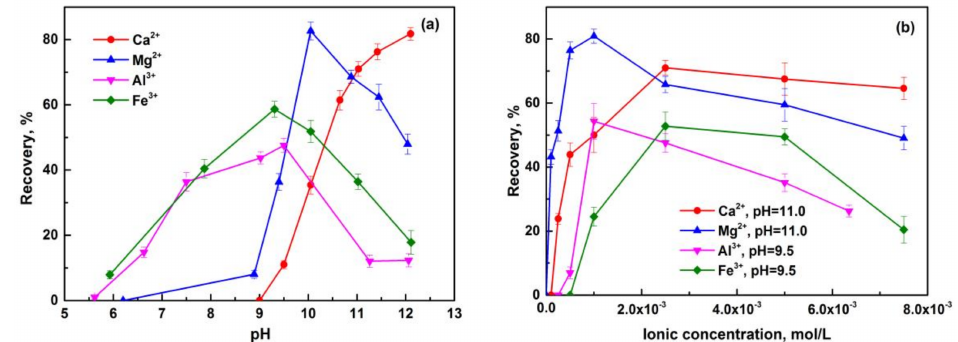
Figure 4. ( a ) Effect of pH on the floatability of quartz in the presence of metal ions at a concentration of 2.5 × 10 − 3 M; ( b ) Effect of ionic concentration on the floatability of quartz at the desired